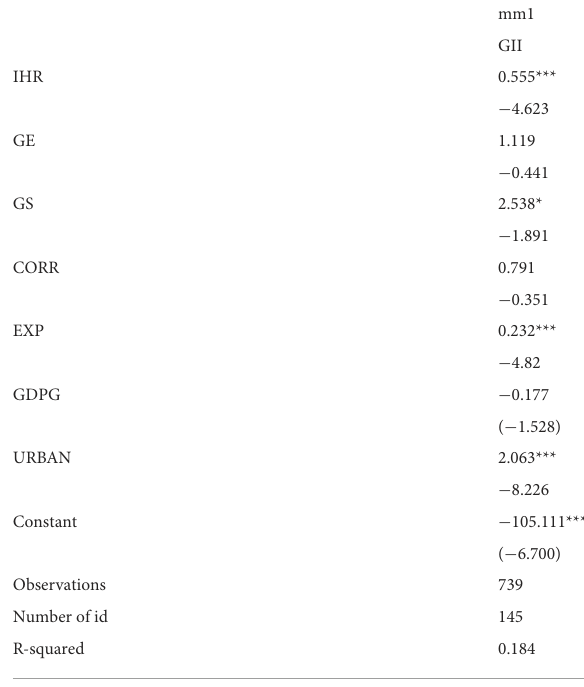
TABLE 4 Effects of public health policy quality on state innovation capacity. Variable